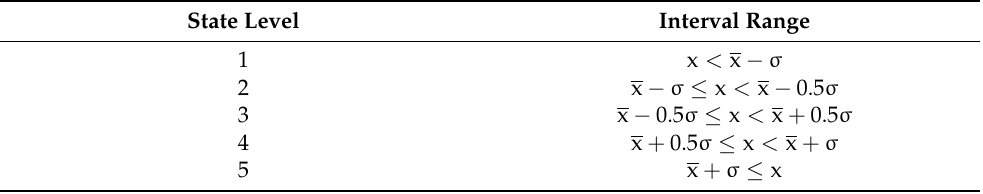
Table 1. State classification standard of mean value (x)-standard ( σ ) deviation